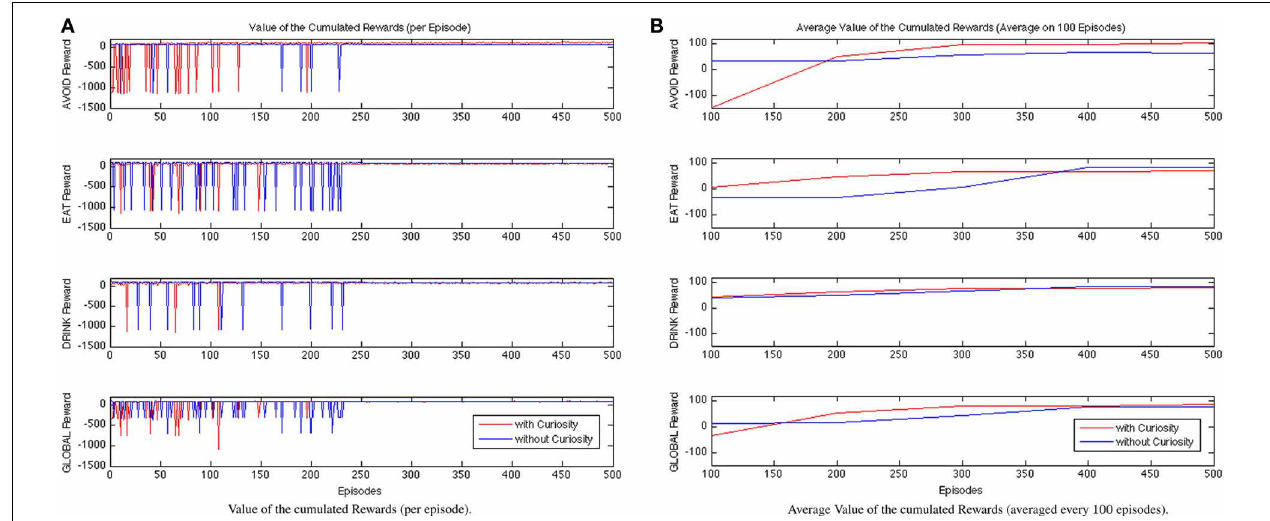
FIGURE 7 | Comparison between CR and NCR rewarding values during learning process evaluated for each episode (A) and considering the data averaged every 100 episodes (B).